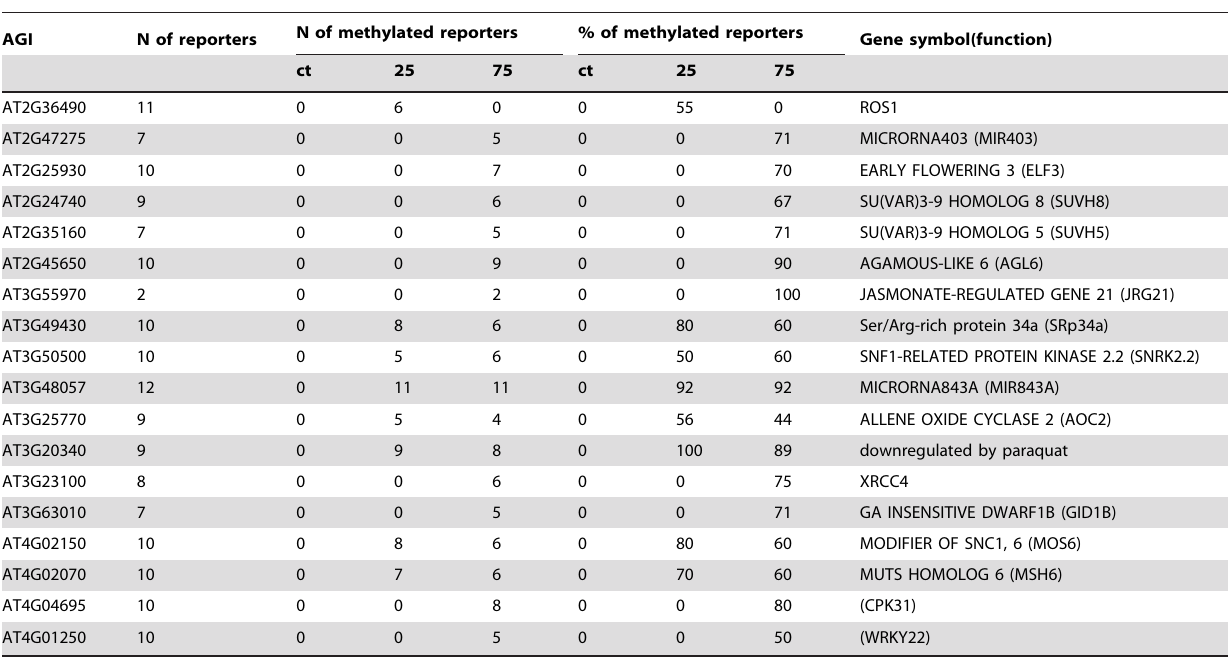
Table 1. Promoters hypermethylated in the progeny of stressed plants.